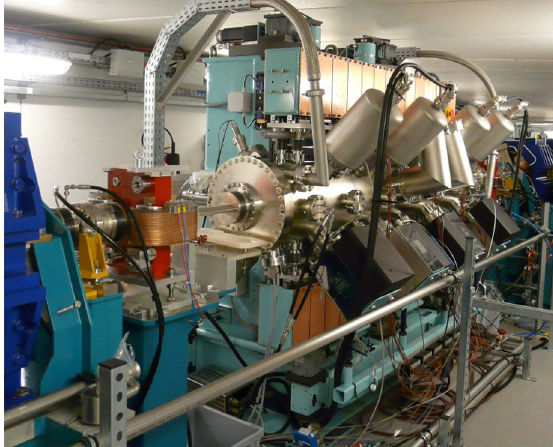
FIG. 16. The cryogenic undulator installed in the SOLEIL storage ring straight section.